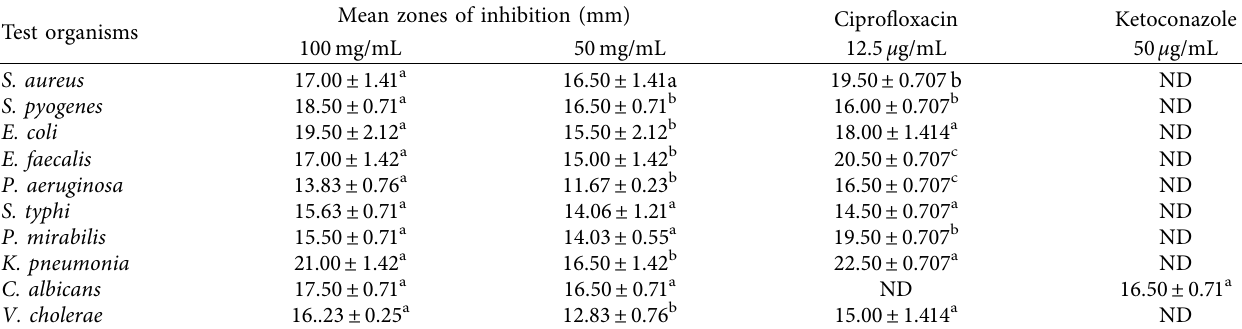
Table 5: Antimicrobial activity of DO5 extract.